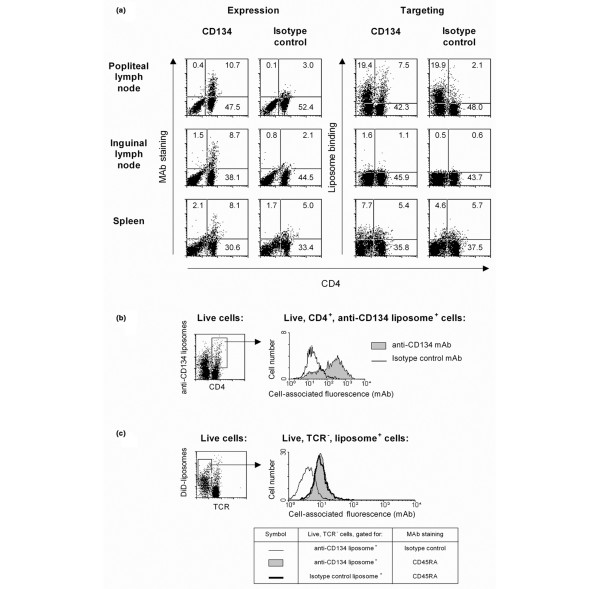
CD134+ T cells in joint-draining lymph nodes are targeted by subcutaneous injection of anti-CD134 liposomes. On day 7 after immunization with Mycobacterium tuberculosis (Mt), rats were injected subcutaneously with fluorescent isotype control liposomes or anti-CD134 liposomes. Rats were killed 30 min later, and popliteal lymph nodes (PLN), inguinal lymph nodes, and spleens were isolated. (a) Cells were stained for CD4 and T-cell antigen receptor (TCR)-αβ and cell-associated fluorescence was analyzed by flow cytometry. Dot plots show cell-associated fluorescence due to in vitro monoclonal antibody (mAb) staining (left panels) or in vivo liposome binding (right panels). Cells were gated for live TCR-αβ+ CD4+ cells. The numbers in the dot plots indicate the percentage of cells above the cut-off line, which was set by using non-stained cells from sham-injected animals. Three rats were analyzed per group; representative stainings of one rat per group were selected and are shown here. (b) PLN cells of anti-CD134 liposome-injected rats were stained with anti-CD4 and anti-CD134 or its isotype control. Cells were gated for live CD4+liposome+ cells. Histograms show cell-associated fluorescence due to the binding of anti-CD134 (filled) or isotype control mAb (open). Representative stainings of one rat of three are shown. (c) PLN cells were stained with anti-TCR-αβ and anti-CD45RA (rat B cells). Cells were gated for live, TCR-αβ-, and liposome+ cells. Histograms show cell-associated fluorescence due to ex vivo CD45RA (filled histogram) or isotype control mAb staining (thin line) on anti-CD134 liposome+ cells, or CD45RA (thick line) mAb staining on isotype control liposome+ cells. Representative stainings of one rat of three are shown.